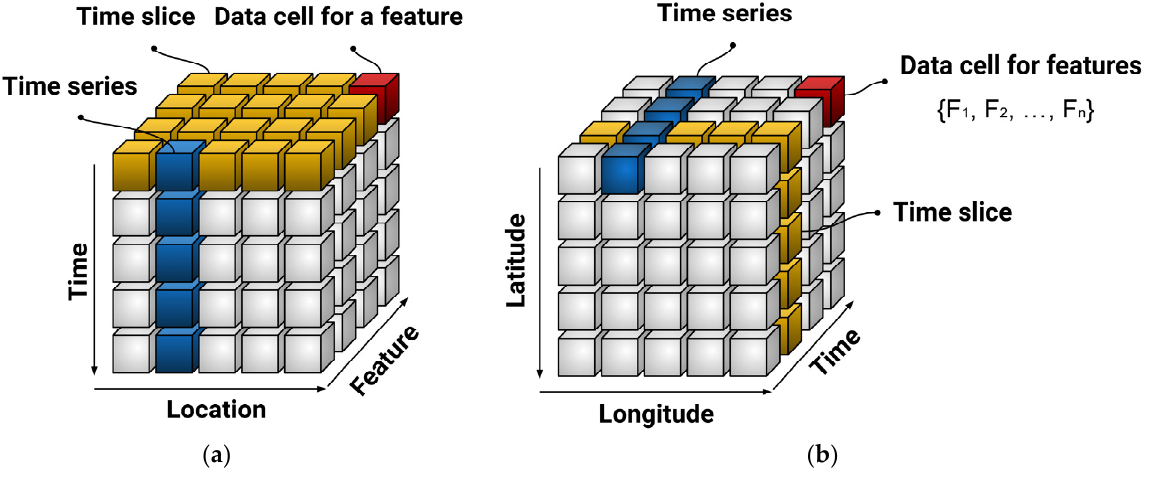
Figure 7. Schematic representation of ML–driven for ( a ) spatiotemporal model, and ( b ) geo-spatiotemporal model.